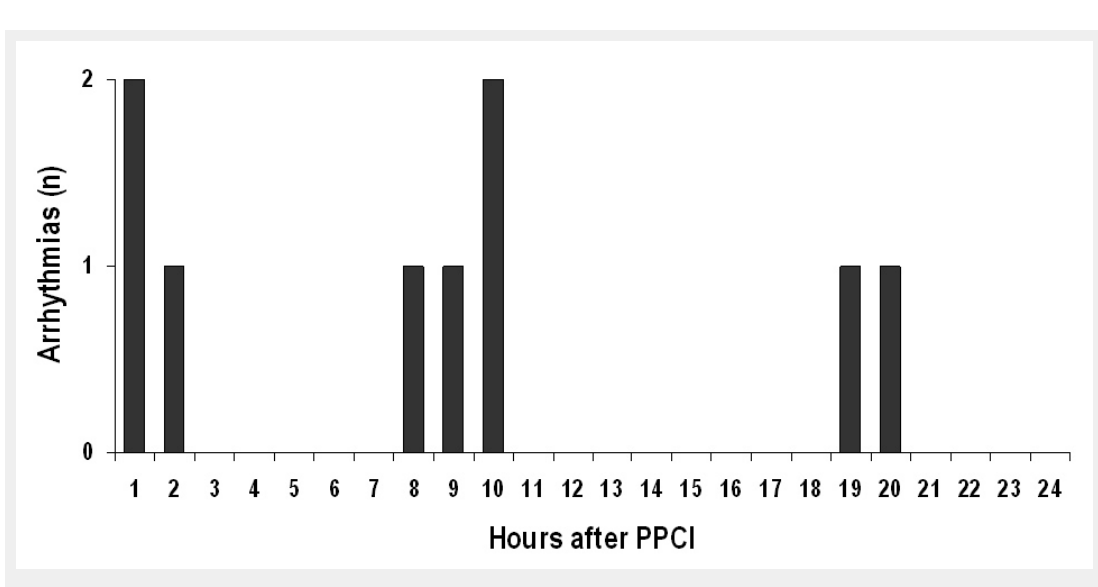
Figure 1 Time of occurrence of post-procedural life-threatening arrhythmias in patients with ST-segment elevation myocardial infarction undergoing primary percutaneous coronary intervention (PPCI). In addition, a single episode of sustained ventricular tachycardia occurred on the 4 th post- procedural day in a patient with hypokalaemia (not